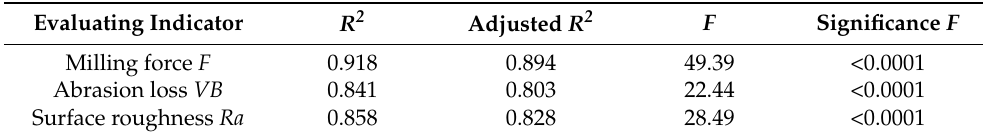
Table 7. Multiple regression equation milling performance significance.